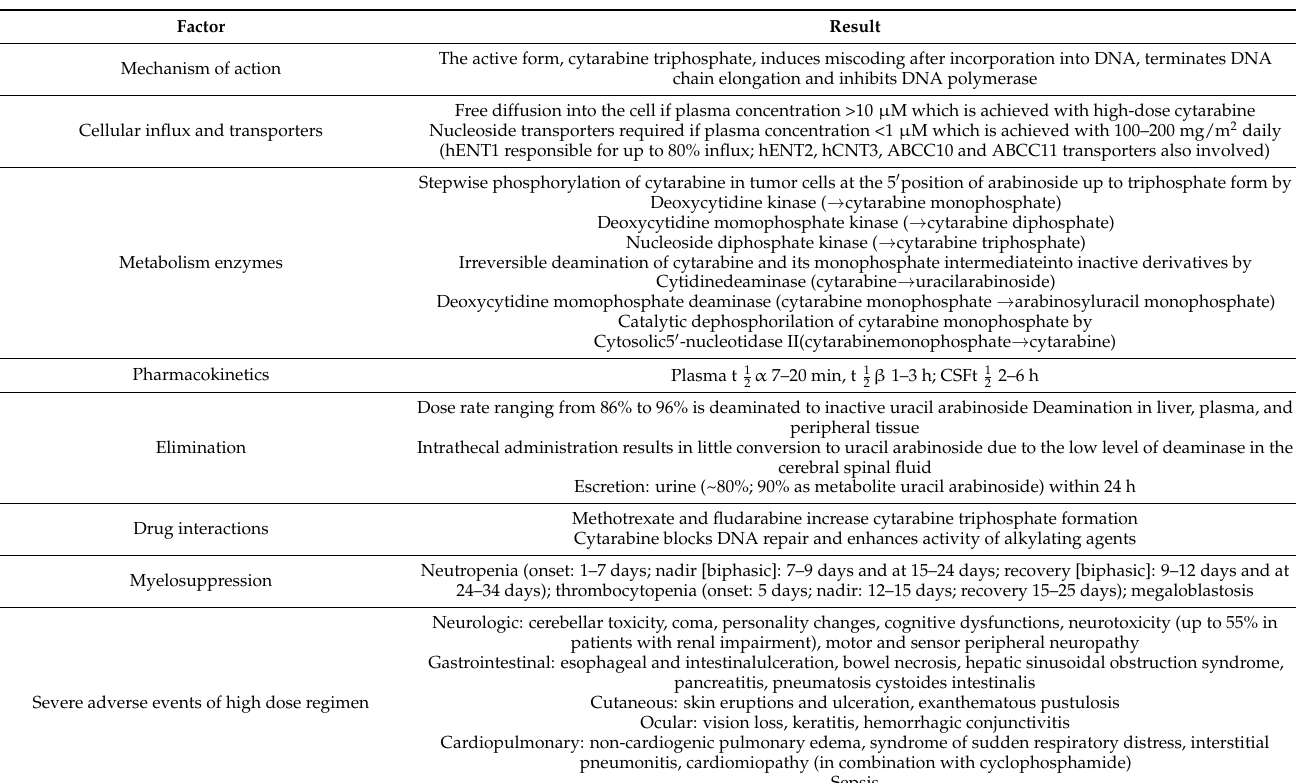
Table 3. Essential features of cytarabine